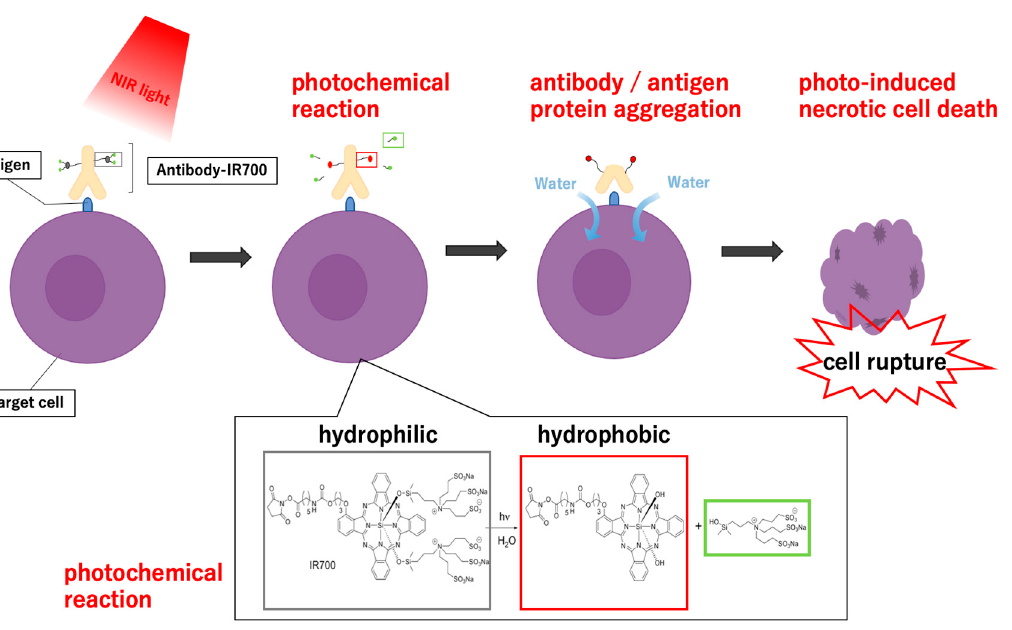
Figure 1. Schematic diagram for cellular cytotoxicity induced by near-infrared photoimmunotherapy (NIR-PIT). First, antibody-IR700 conjugates bind to molecules on the cancer cell membrane; when exposed to NIR light, a photochemical reaction occurs. These photochemical reactions can dramatically alter the physical characteristics of reactive molecules. In detail, the side-chain silanol groups of hydrophilic silicon phthalocyanine are released, changing IR-700 from hydrophilic to hydrophobic. Then, the added antibody proteins aggregate along with the antigens bound to the antibody’s gate, causing physical damage to the cell membrane. Finally, the water outside the cell flows into the cell to burst it, leading to necrotic cell death.